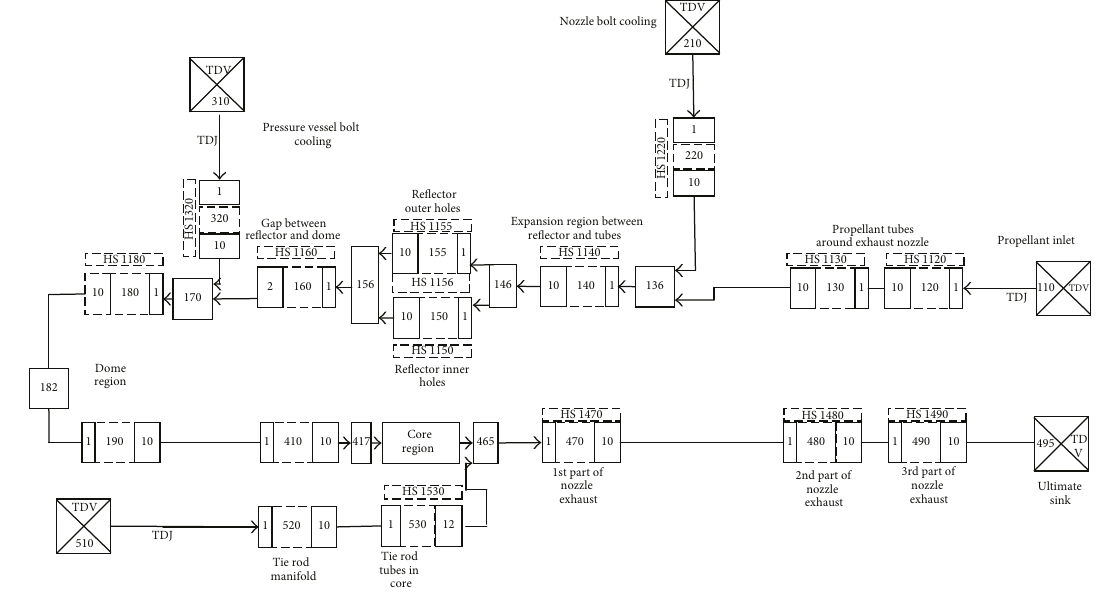
Figure 7: Overall RELAP5 nodalization diagram of Pewee I.